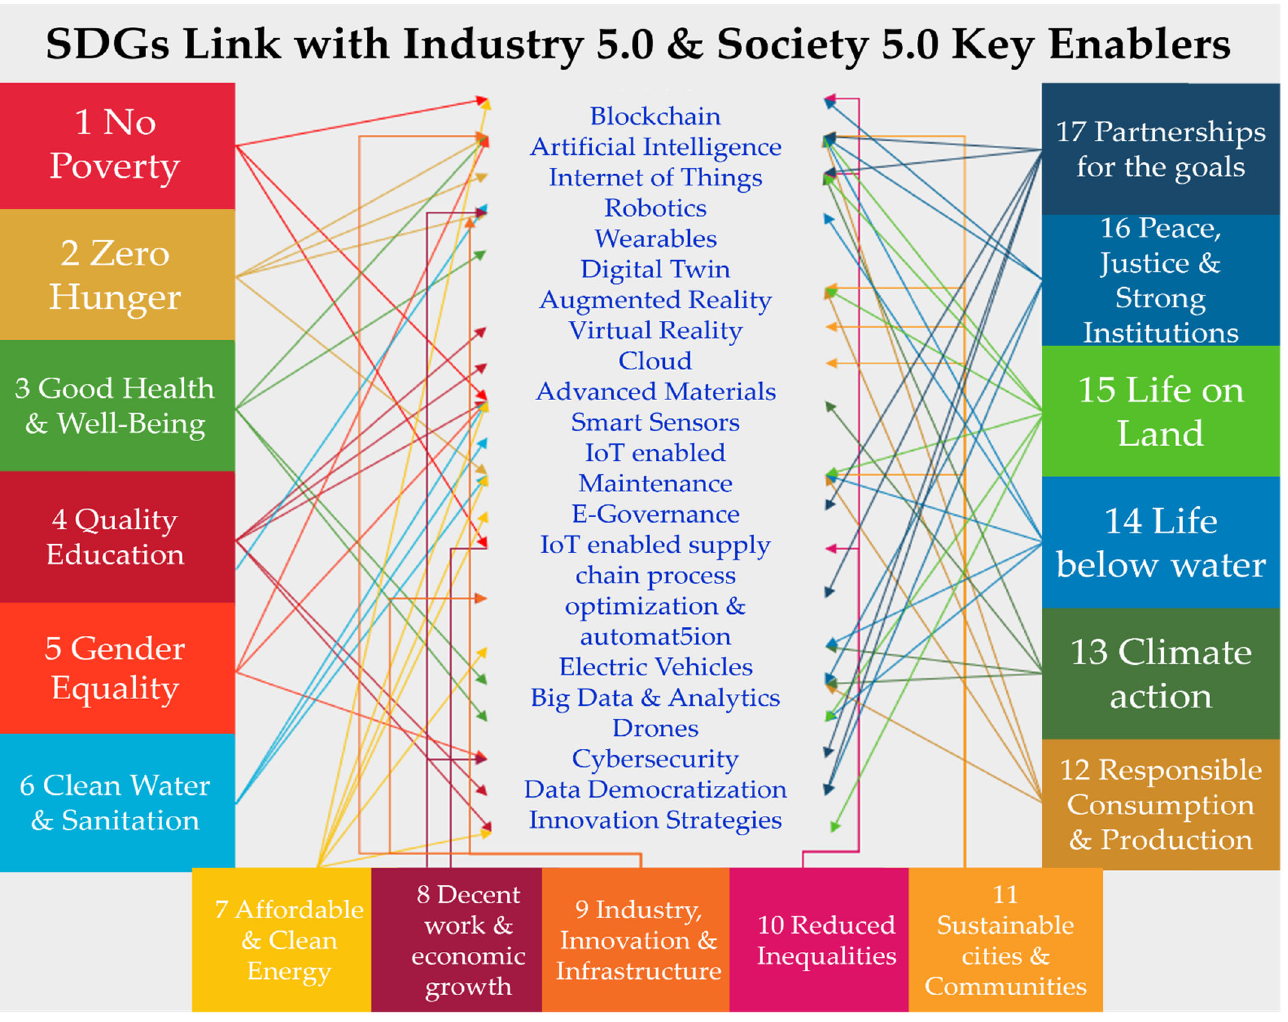
Figure 6. Society 5.0 for Sustainable Development Goals.